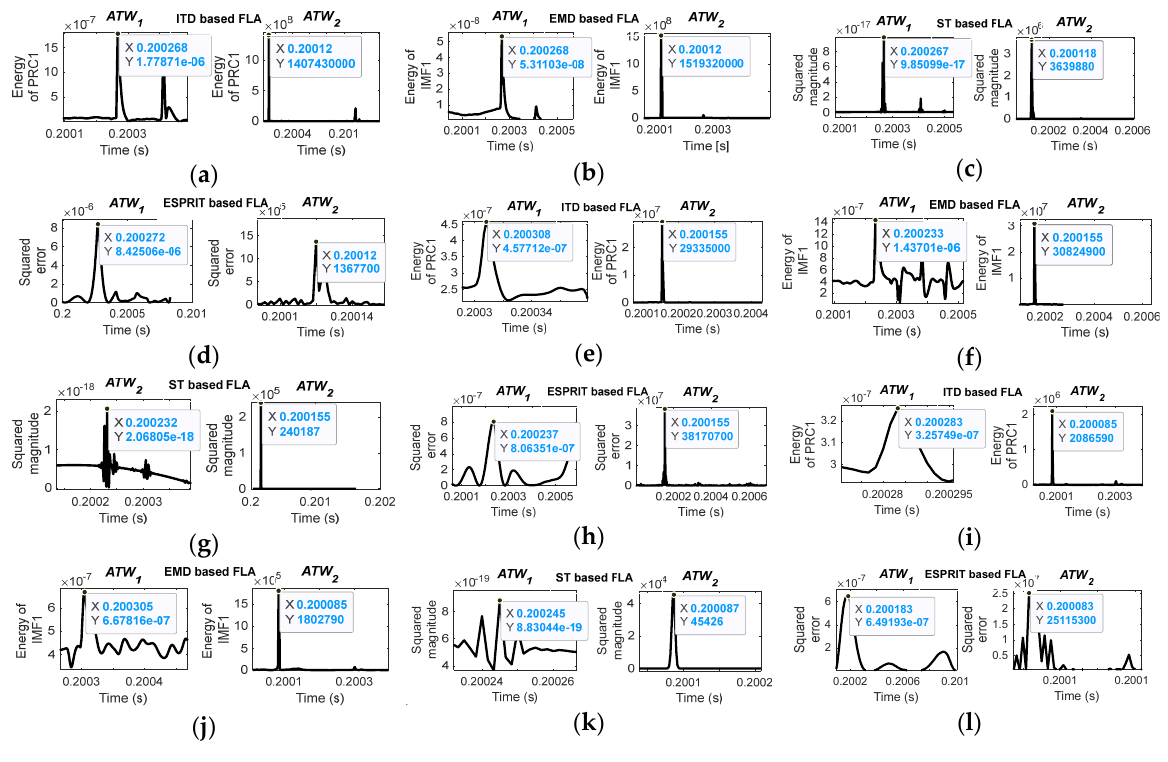
Figure 12. Estimation of ATWs for Kundur power system for faults after UPFC. ( a – d ) Estimated ATWs for Scenario 3. ( e – h ) Estimated ATWs for Scenario 4. ( i – l ) Estimated ATWs for Scenario 5.